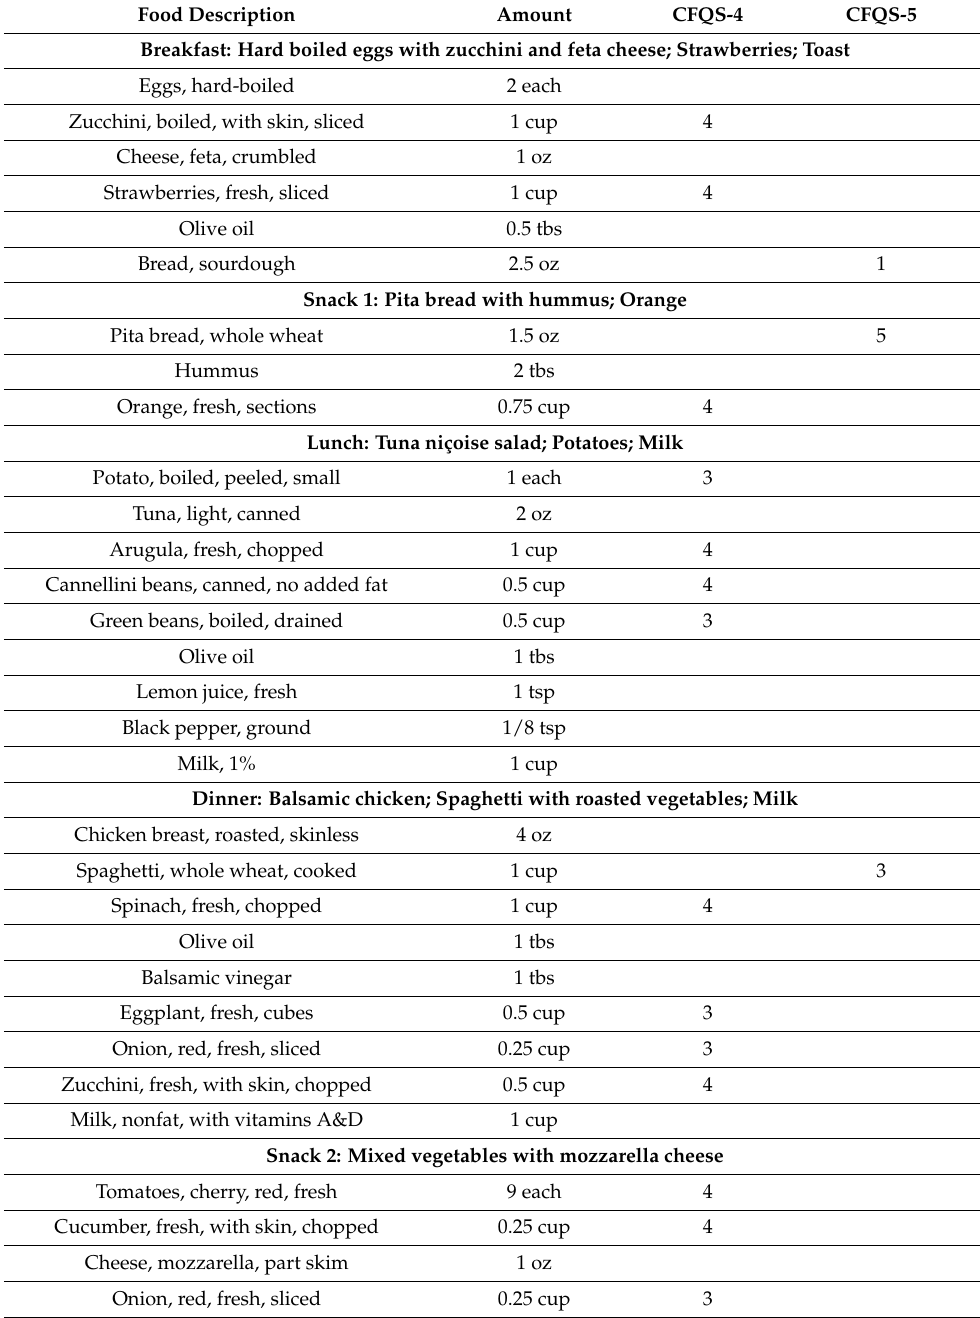
Table 8. Sample Daily Menu: Healthy